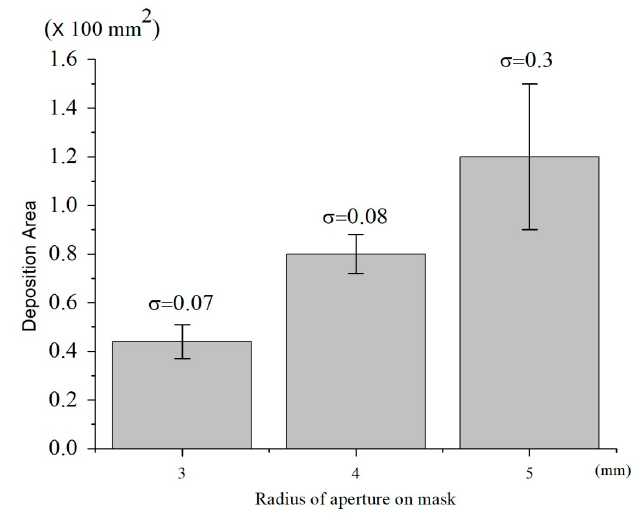
Figure 8. Effects of aperture size on particle deposition stability. Data are shown with mean ± SD ( n = 3).